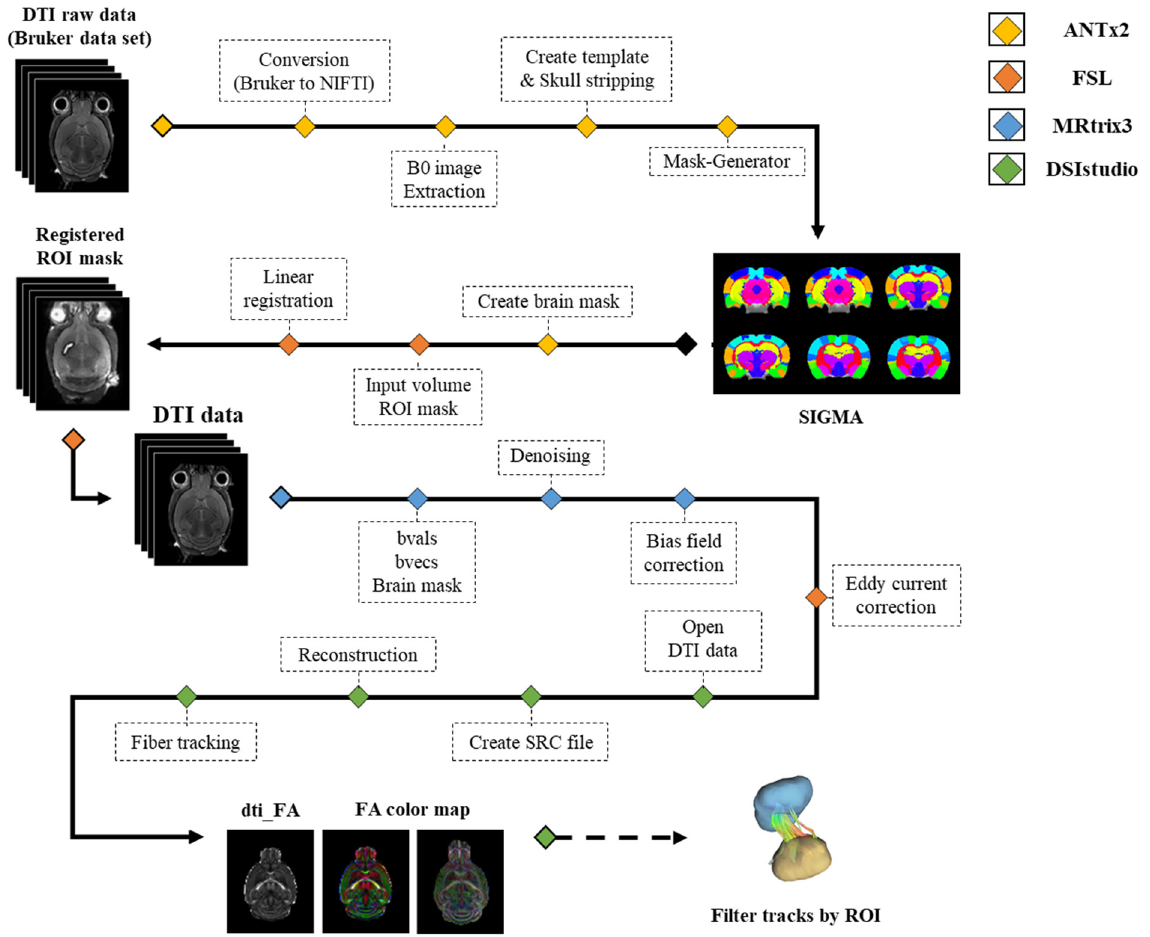
Figure 1. All analysis pipeline of the image data. Abbreviation: ANTx2, Atlas Normalization Toolbox using elastix 2; FSL, FMRIB software library; ROI, Region Of interest; FA, Fractional anisotropy; DTI, Diffusion tensor Image; NIFTI, Neuroimaging informatics technology initiative.